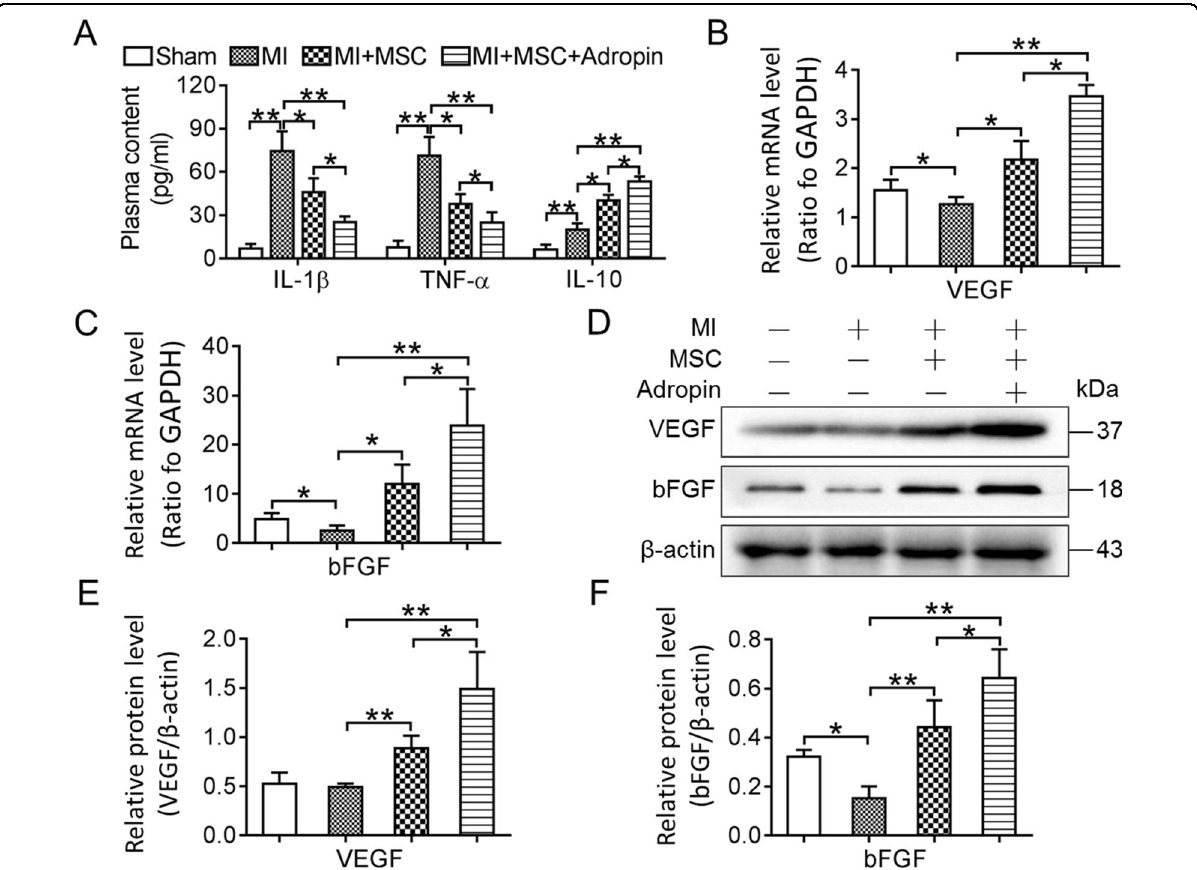
Fig. 4 Modi fi ed in fl ammatory microenvironment and enhanced paracrine mechanism by adropin-based dual treatment with MSCs transplantation in rat myocardial infarction. A Plasma concentration of IL-1 β , TNF- α , and IL-10 was detected by ELISA at day 3 after cell therapy to evaluate systemic in fl ammation induced by MI. B , C Real-time PCR was used to assess the gene expression of paracrine cytokines VEGF and bFGF in the infarcted myocardium at day 28 after cell therapy. D , E , F Western blotting was performed to evaluate the protein expression of VEGF and bFGF at day 28. IL-1 β Interleukin-1 β . TNF- α Tumor necrosis factor. IL-10 Interleukin-10. VEGF Vascular endothelial growth factor. bFGF Basic fi broblast growth factor. MSCs and MI, see Fig. 1. Data are expressed as mean ± SD, n = 8. * p < 0.05; ** p <